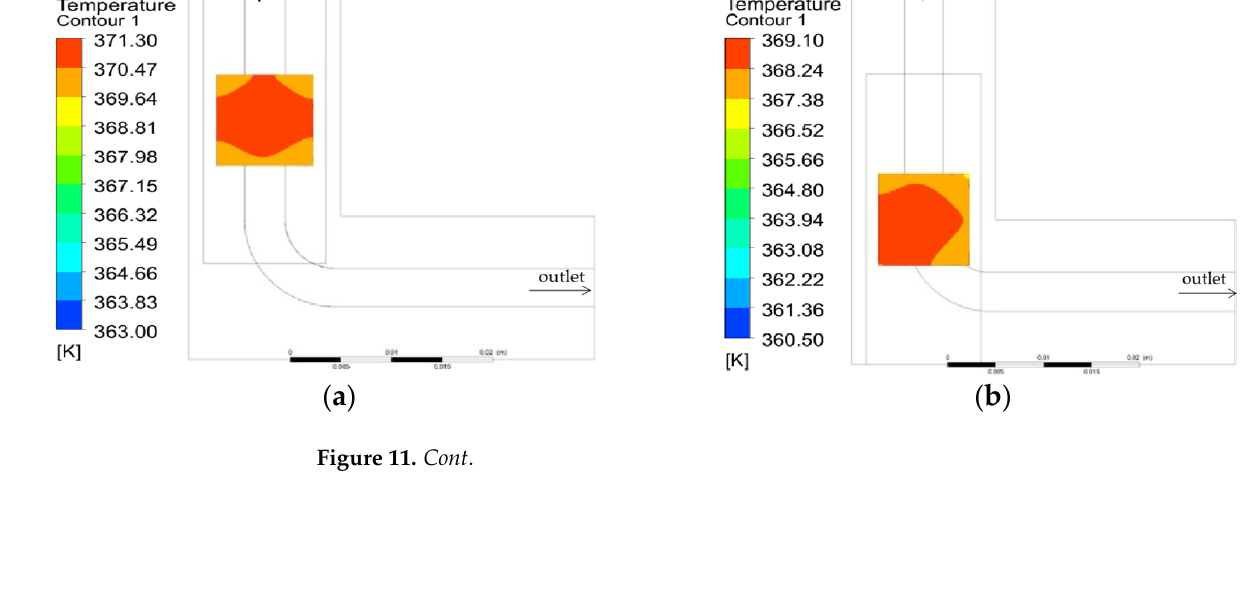
Table 5. Numerical results of different heat source positions.